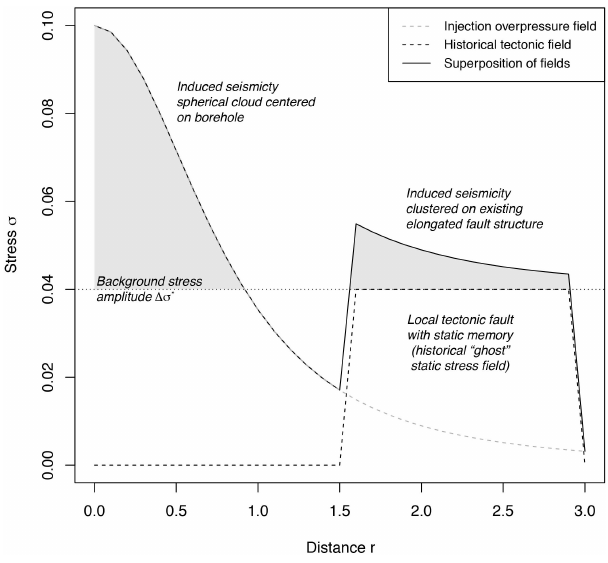
Figure 5. Sketch on how anisotropy and other types of hetero- geneities can be implemented in the geometrical approach by adding a historical tectonic static stress field (ad hoc parameter values used for sake of simplicity). Here a past overloading field + (cid:49)σ ∗ ) on a nearby fault would have been “planed” to the ( σ > σ ∗ 0 + (cid:49)σ ∗ by temporal diffusion (Eq. 14), leaving only threshold σ ∗ 0 a “ghost” of that historical static stress field (for the homogeneous case, see Fig.